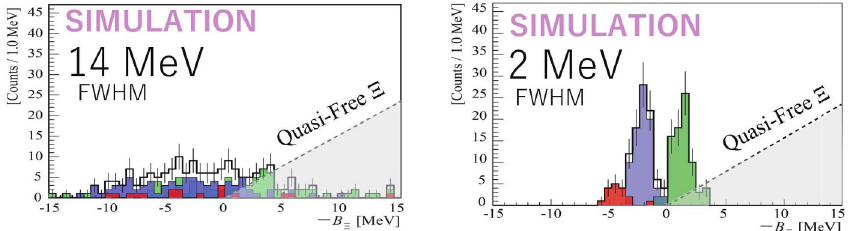
Figure 2. Expected spectra of the Ξ binding energy taken with the negative sign ( − B Ξ ) for the reaction of 12 C( K − , K + ) 12 Λ Be. Assumed energy resolutions in the left and right panels are 14 and 2 MeV in FWHM, respectively. J-PARC E70 aims to achieve the 2-MeV resolution in FWHM (right panel). The peak positions and relative peak strengths for the assumed three states ( J π = 1 − are shown in di ff erent colors, are taken from a prediction by DWIA with the interaction model of ESC08a